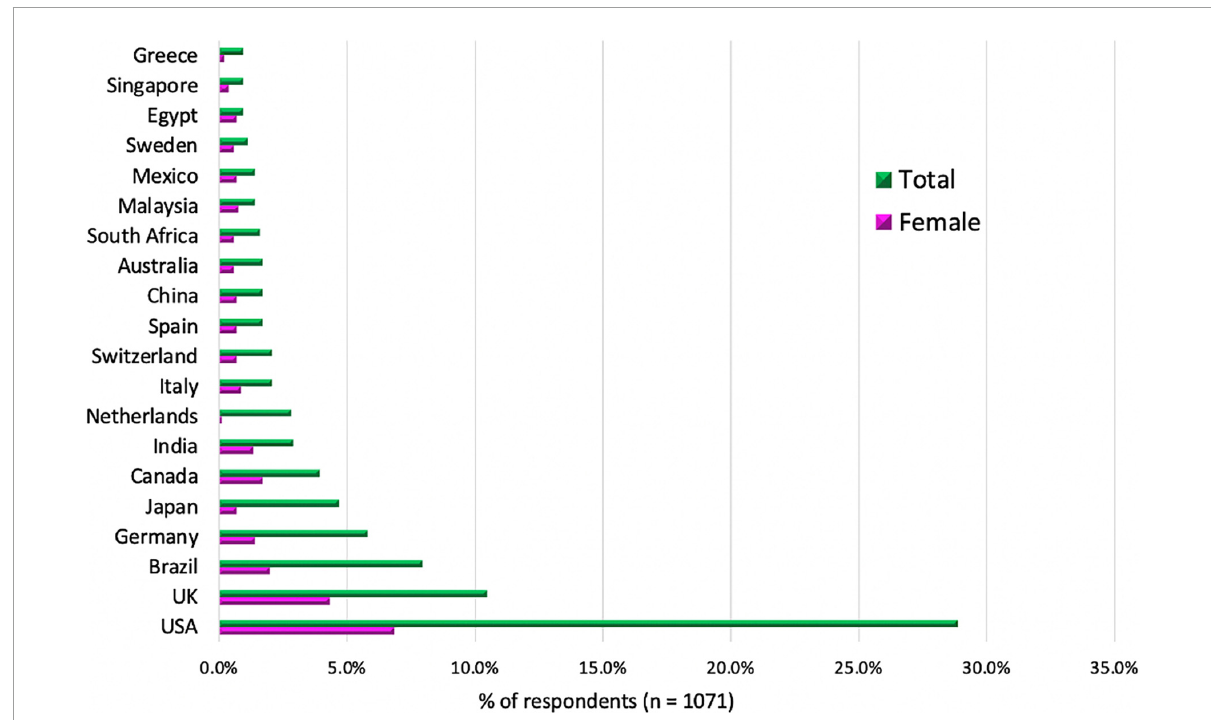
FIGURE2 Top 20 countries of origin of surveyed respondents ( n = 1,071). The top 20 countries with the most respondents are shown. The data from all other respondent countries are not displayed in the graph. The detailed description of the responders and their gender (within parentheses) were as follows, for USA 309 (F:73/M:236), UK 112 (F:46/M:66), Brazil 85 (F:21/M:64), Germany 62 (F:15/M:47), Japan 50 (F:7/M:43), Canada 42 (F:18/M:24), India 31 (F:14/M:17), the Netherlands 30 (F:1/M:29), Switzerland 22 (F:7/M:15), Italy 22 (F:9/M:13), China 18 (F:7/M:11), Australia 18 (F:6/M:12), Spain 18 (F:7/M:11), South Africa 17 (F:6/M:11), Malaysia 15 (F:8/M:7), Mexico 15 (F:7/M:8), Sweden 12 (F:6/M:6), Egypt 10 (F:7/M:3), Greece 10 (F:2/M:8), Singapore 10 (F:4/M:6). The rest of the surveyed countries are described in the Supplementary material